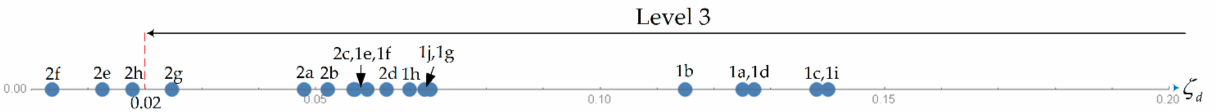
Figure 6. Level 3 Handling Qualities for the dutch roll mode.